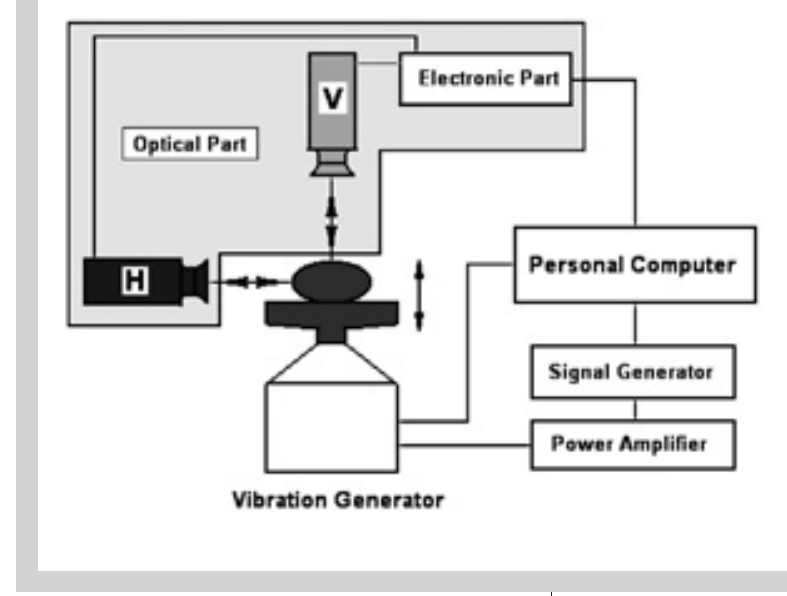
Figure 1: Laser Doppler vibrometer (LDV) applied to forced vibrating object. LDV has optical and electronic parts. The optical part can be arranged into two basic positions: vertical (V) and horizontal (H). The vibration generator induces vertical forced vibrations in the spheroidal product lying freely on its